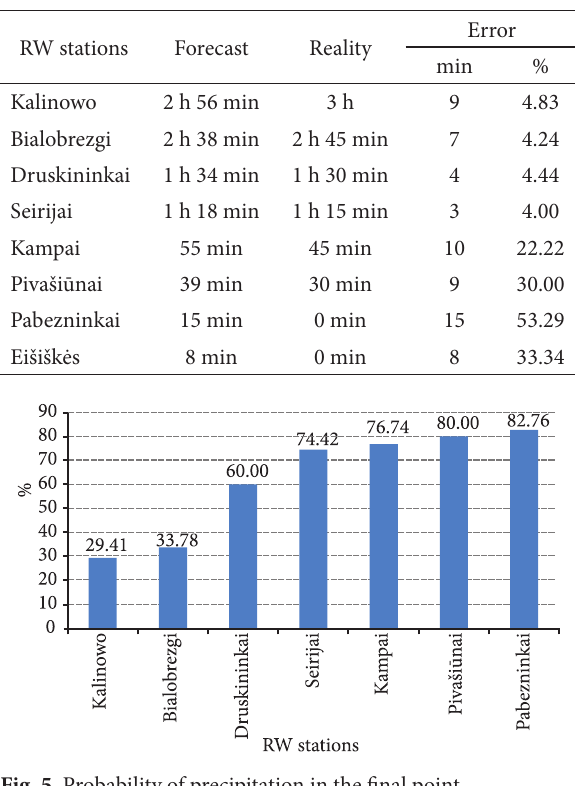
Table 4. Results of research made on 10 February